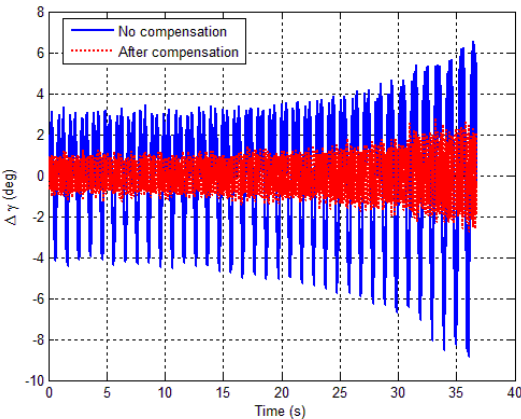
14 of 16 solid blue line represents the pitch angle error before correction, and the dotted red line represents the pitch angle error after correction. It can be seen that the attitude error increases with time.